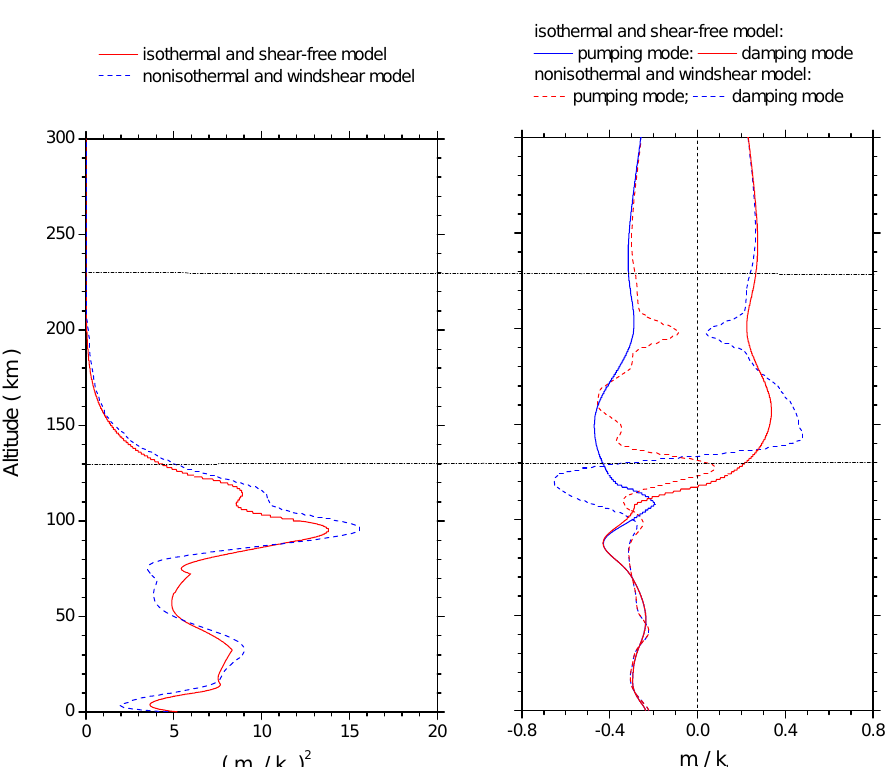
Figure 7. Effect of isothermality and wind shear on two ordinary dissipation wave modes from the Z 6 -dispersion equation, Equation (18), applicable for the region below a 230-km altitude.